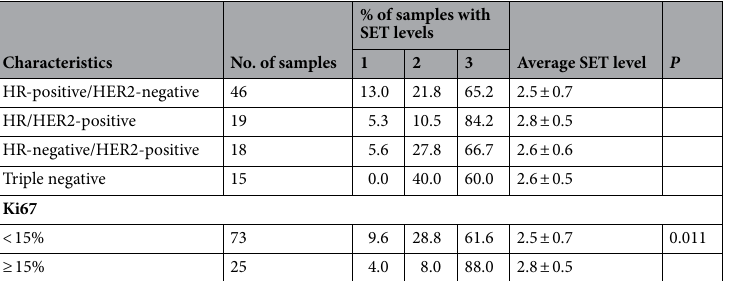
Characteristics No. of